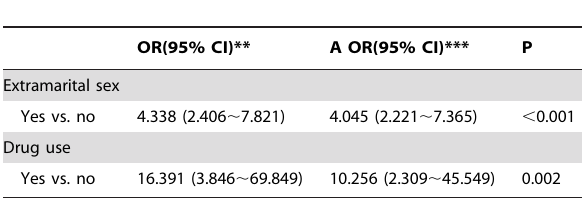
Table 5. Logistic regression analysis of HCV